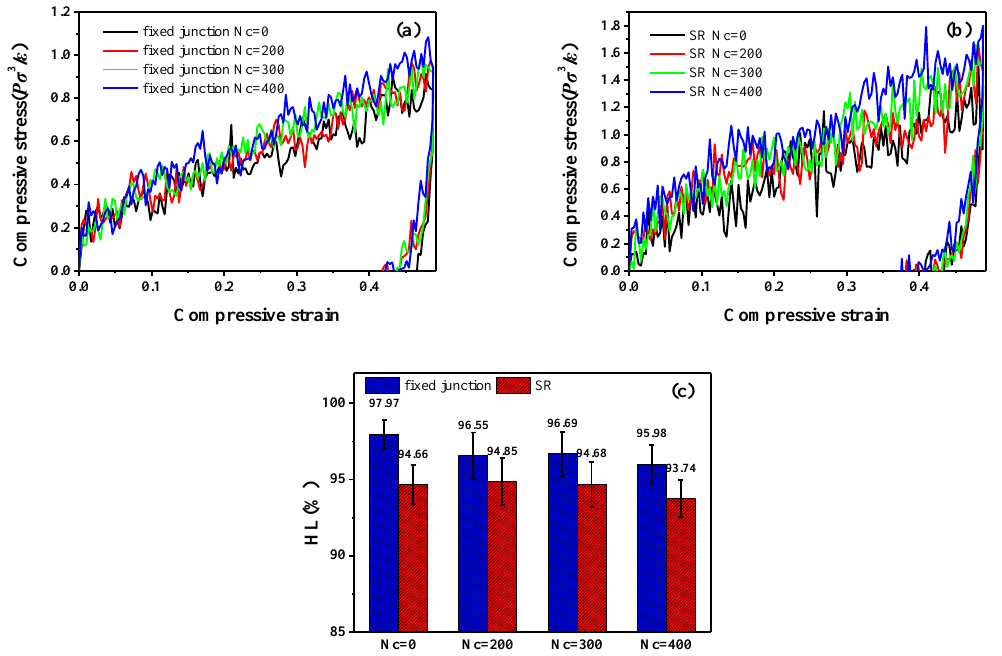
Figure 12. Compression-recovery curves for different number of cross-linked bonds; Nc in ( a ) the fixed junction systems and ( b ) SR systems, ( c ) hysteresis loss (HL) during the compression-recovery process for different number of cross-linked bonds, and Nc in the fixed junction systems and SR systems.